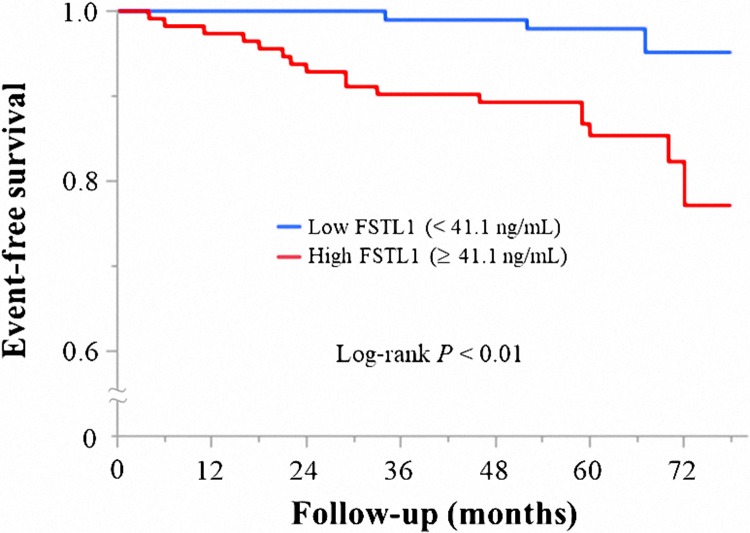
Event-free survival for MACCE.Kaplan–Meier analysis revealed that the MACCE rate was significantly higher in patients with FSTL1 (≥ 41.1 ng/mL) than in those FSTL1 < 41.1 ng/mL (P < 0.01). FSTL1, follistatin-like 1; MACCE, major adverse cardiac or cerebrovascular events.